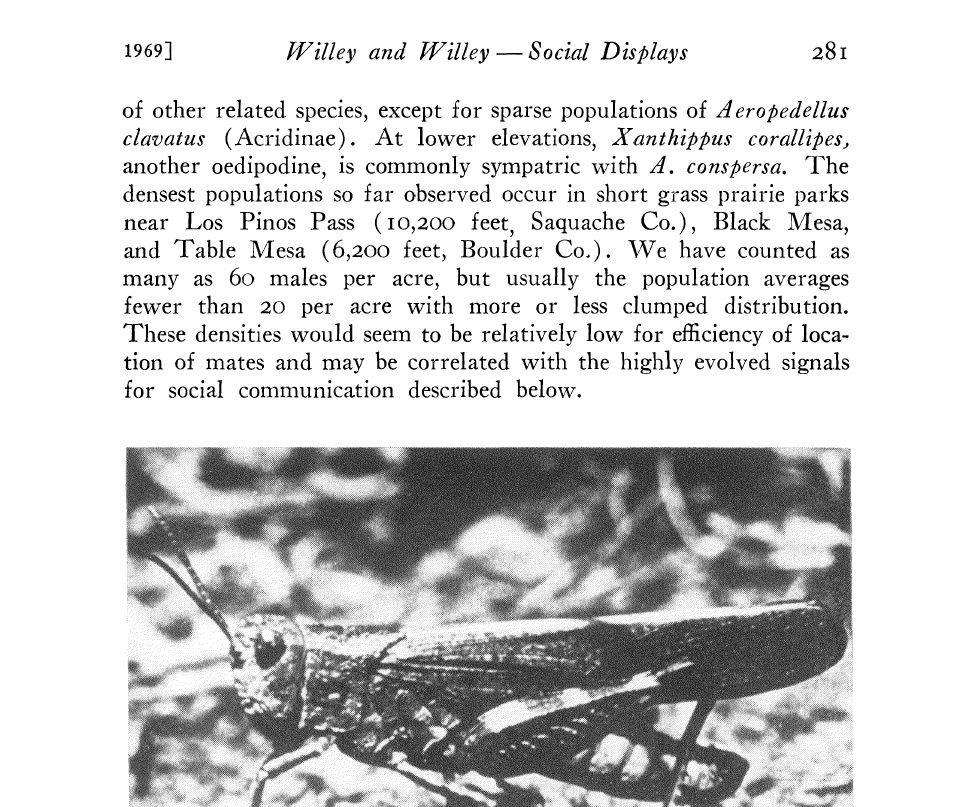
Figure 1. Male A. conspersa in alert pose, Table Mesa, Boulder Co. This male also was buzzing with the right hind leg (visible as 2 faint diagonal